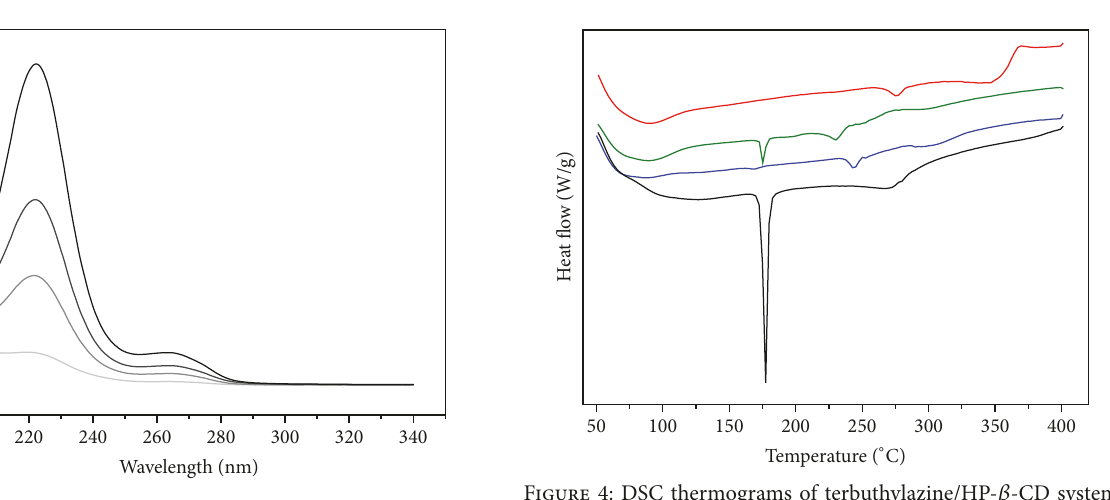
Figure 4: DSC thermograms of terbuthylazine/HP- 𝛽 -CD system: (— black) terbuthylazine; (— red) HP- 𝛽 -CD; (— green) physical mixture; (— blue) inclusion